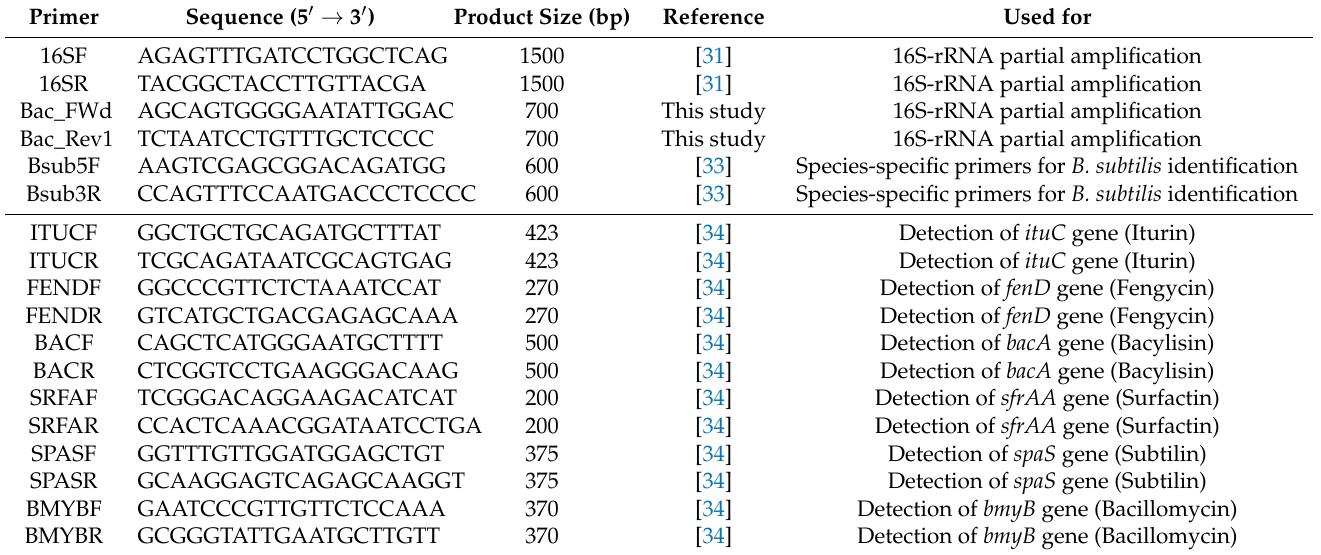
Table 2. Primers used in this